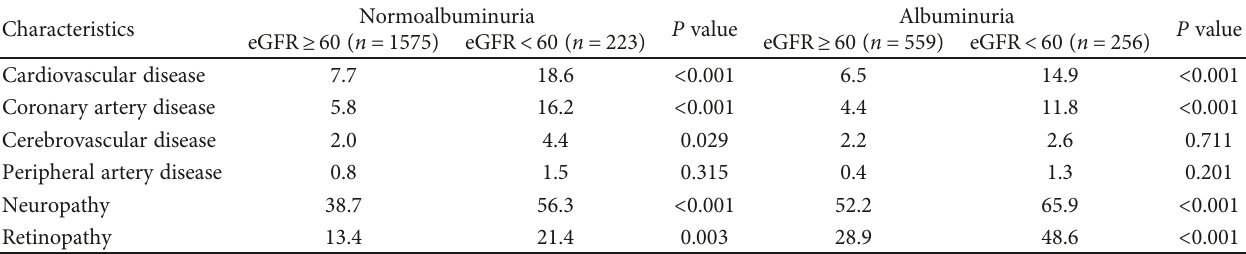
Table 2: The prevalence of chronic complications according to the albuminuria and eGFR group. Characteristics